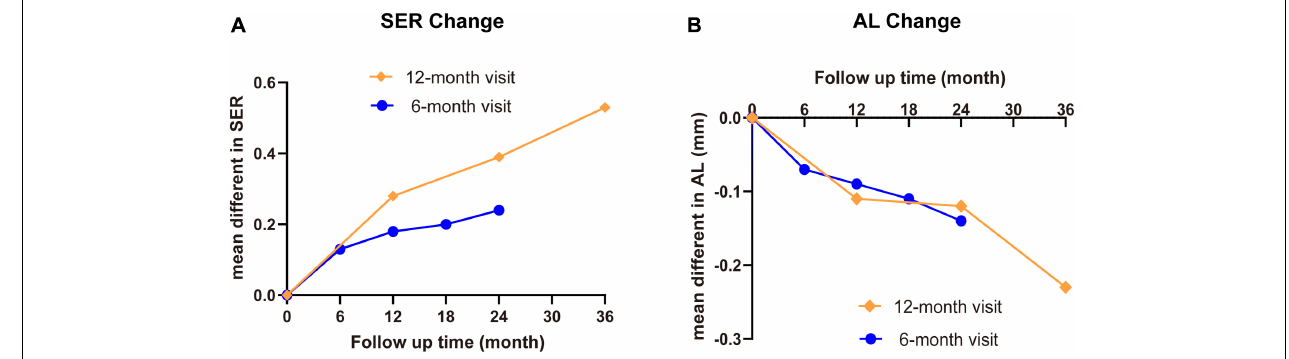
FIGURE 7 | The summary of SER and AL change with MFL treatment in school-aged children. The mean differences of SER (A) and AL (B) between MFLs (intervention) and SVLs (control) with different visit intervals were